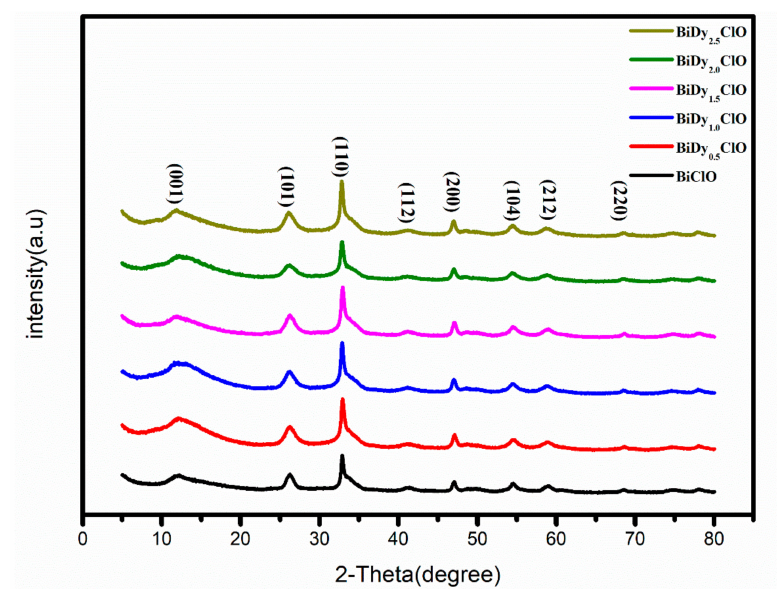
Figure 1. XRD patterns of pure BiOCl and Dy-doped BiOCl.